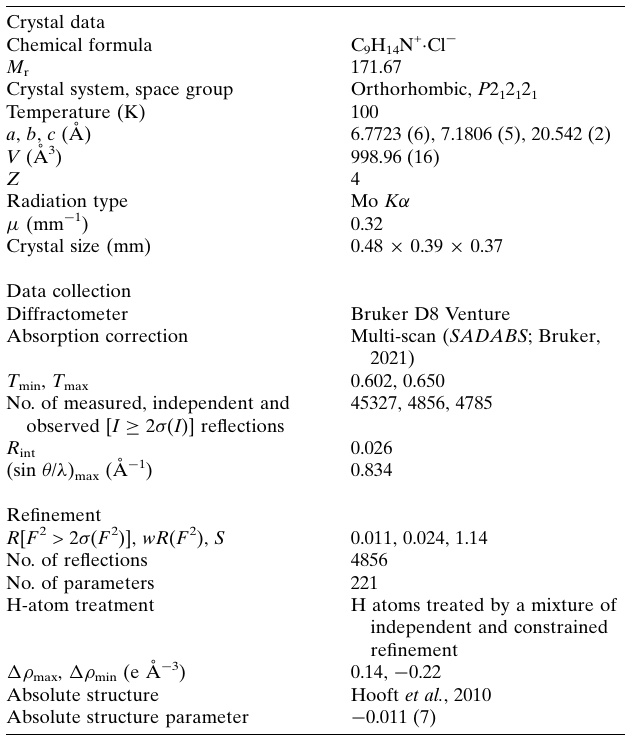
Table 2 Experimental details. Crystal data Chemical